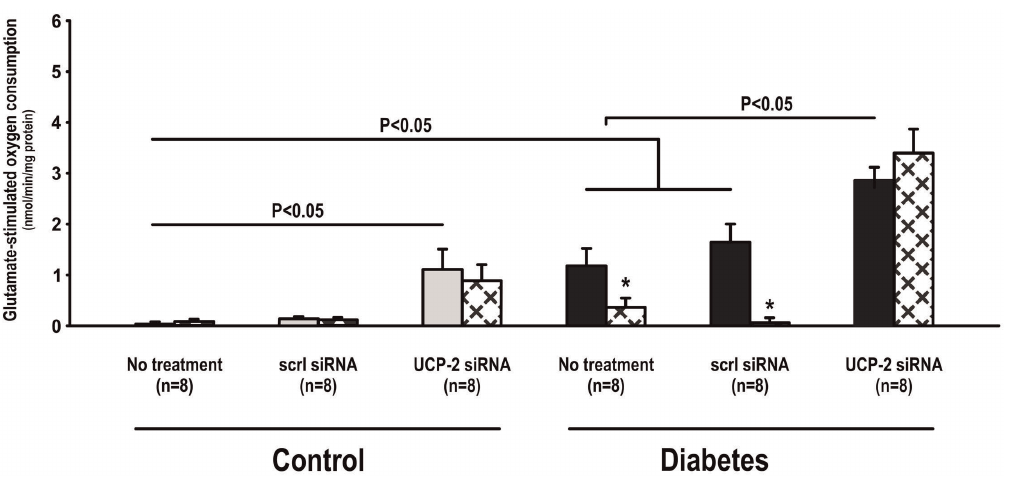
Figure 3. Mitochondria uncoupling measured as glutamate-stimulated O 2 consumption during inhibition of the ATP-synthase with oligomycin during baseline (filled bars) and after inhibition of UCP-2 with GDP (patterned bars) in control and diabetic animals with and without scrambled or UCP-2 siRNA. * denotes p , 0.05 vs. baseline within the group.